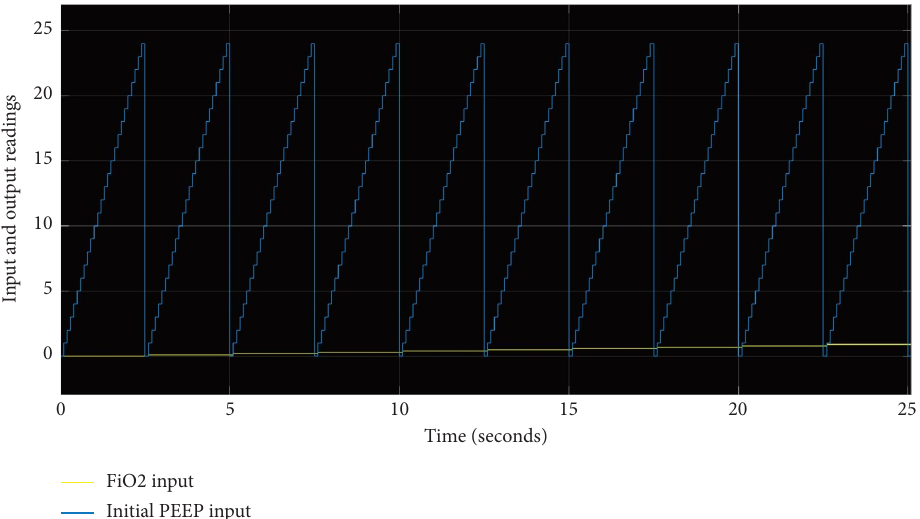
Figure 13: FiO 2 input and non-fuzzifed initial PEEP input graph.